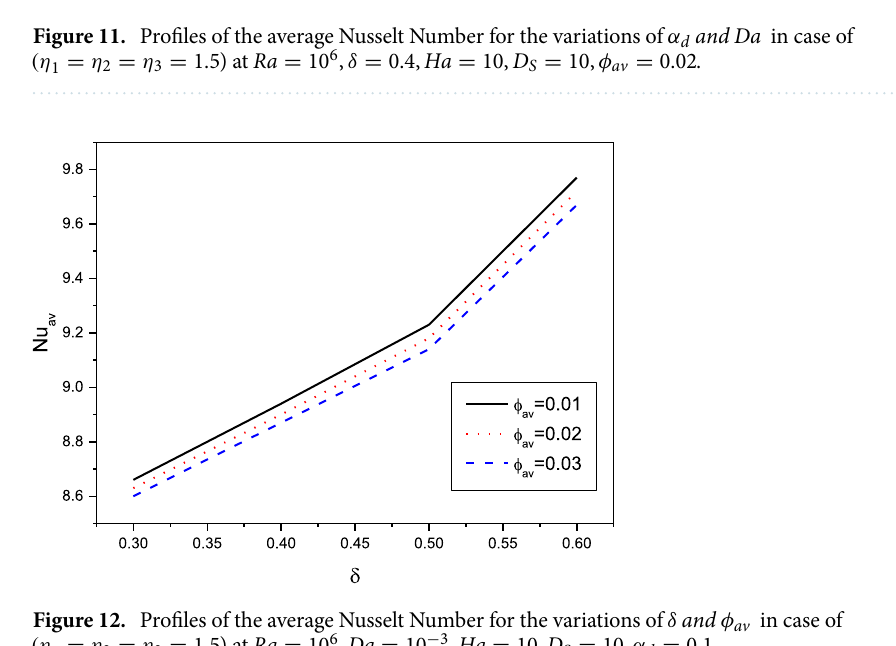
3 , Ha 10 6 , Da 10 10, D 10, α S = − d = = = =